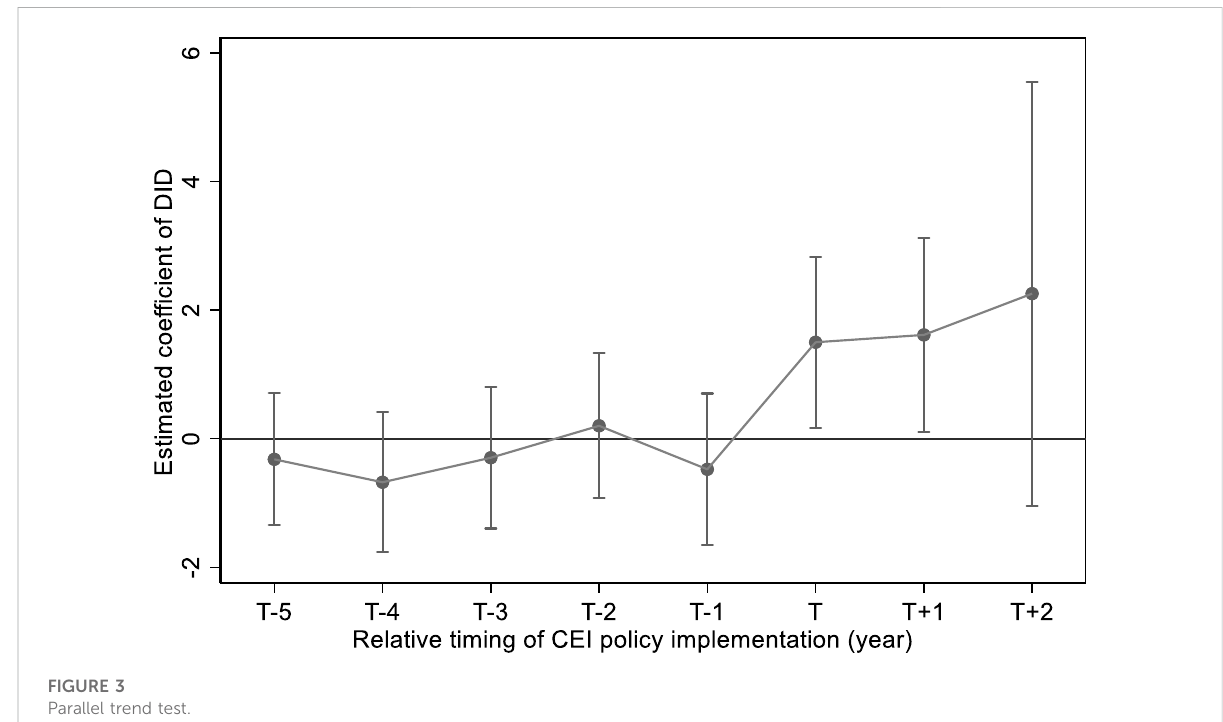
FIGURE 3 Parallel trend test.